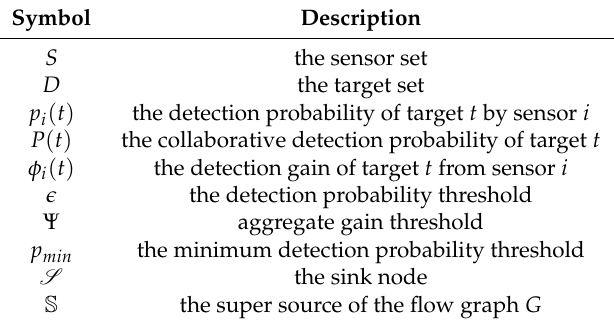
Table 1. Summary of